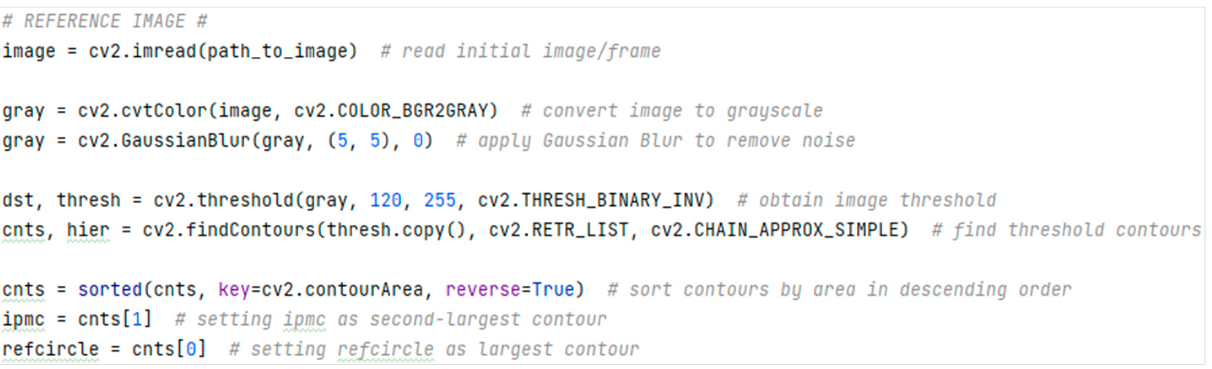
Figure 5. Use of OpenCV to load, manipulate and analyse image.